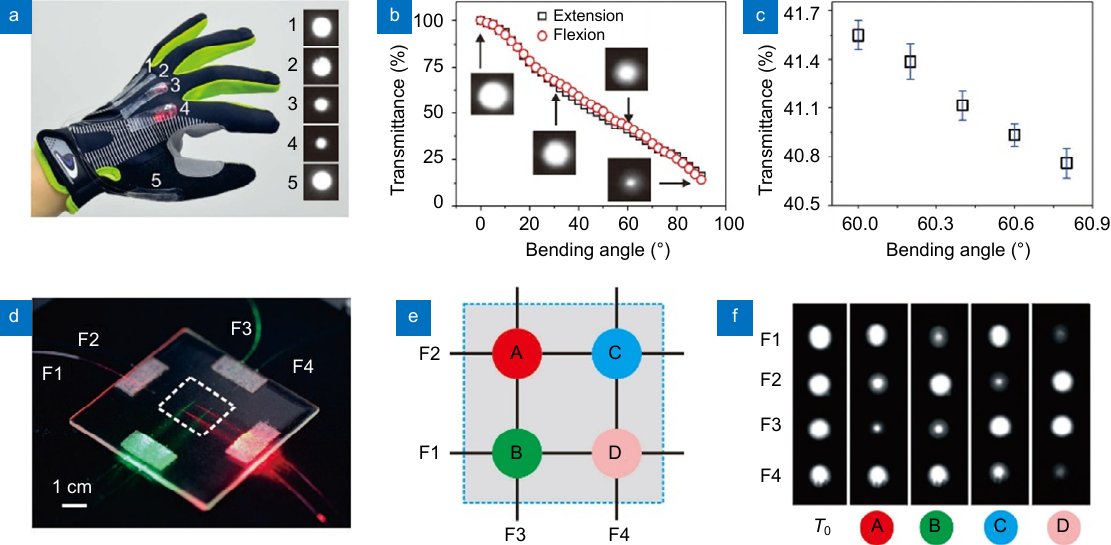
Fig. 4 | Optical data gloves and SLWOS with perpendicularly intersected 2×2 MNF arrays. ( a ) Photograph showing a five-sensor data glove integrated with 5 SLWOSs. ( b ) Bending-angle-dependent output of a typical SLWOS. ( c ) Close-up view of the SLWOS output within bending angles of 60.0°–60.8°. ( d ) Photograph showing a SLWOS consisted by a perpendicularly intersected 2×2 MNF array. ( e ) Schematic of the sens- ing areas for tactile sensing. ( f ) Logic outputs of a 4-input/output-port